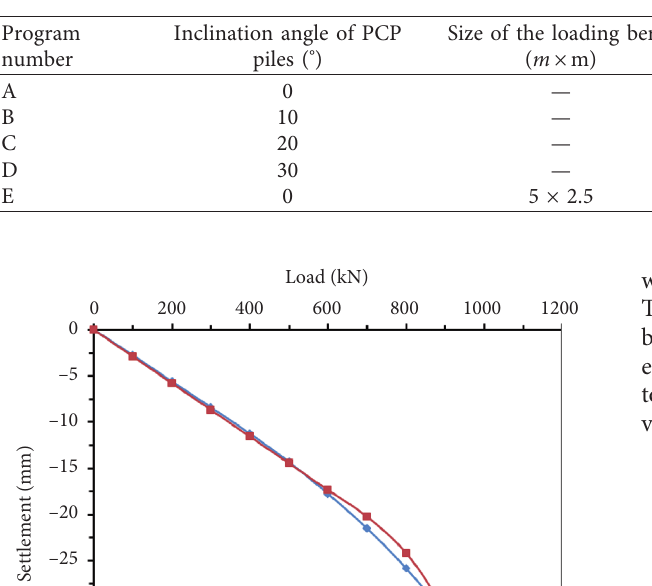
Figure 7: Fem model. (a) Model layout and (b) the actual model. Table 1: Model configuration.